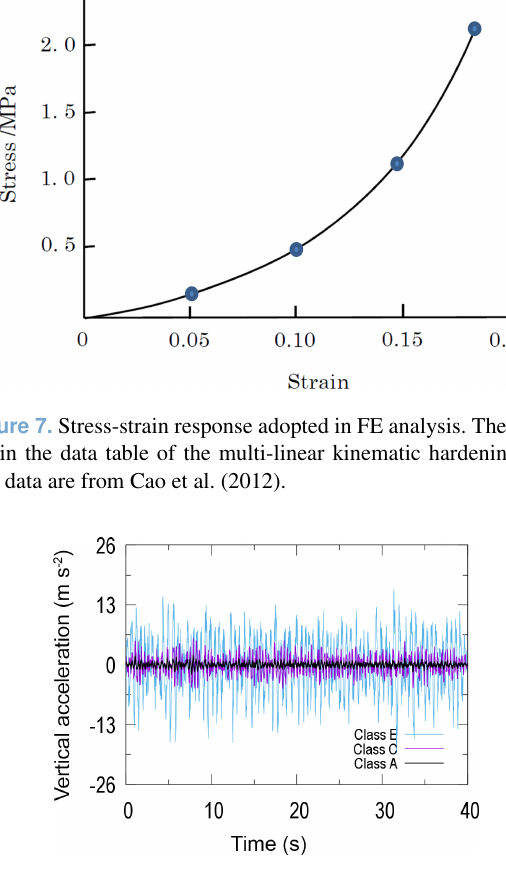
Figure 8. Vertical accelaration of the